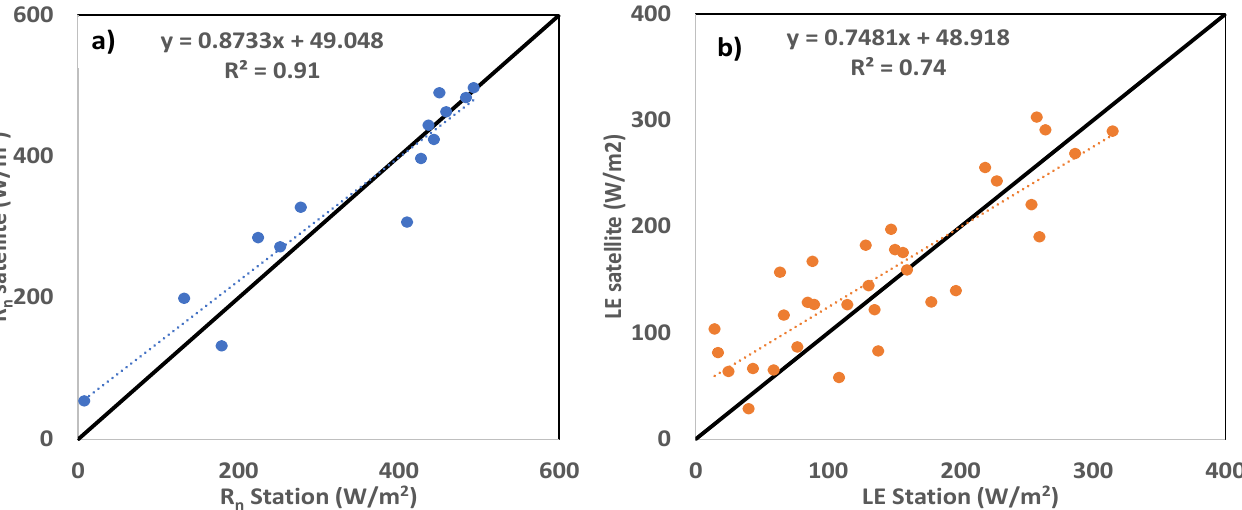
Figure 3. ( a ) Comparison of R n fluxes measured at the Borgo Cioffi field station for 14 different dates, with the R n fluxes retrieved from data acquired by Landsat-8 OLI/TIRS, after applying Equation (4). ( b ) The same comparison but for the LE fluxes, using data acquired at both sites and for all the 32 dates selected in this study. Table 1. Statistical results for the ground–satellite comparison of Rn, S-SEBI LE, and daily